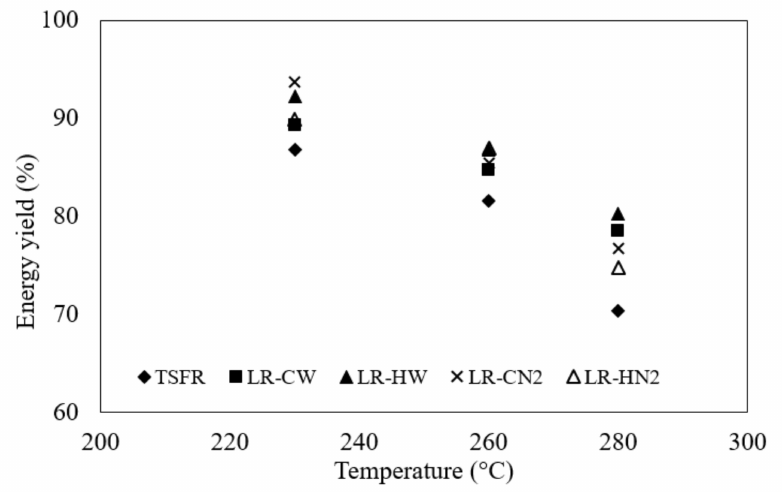
Figure 10. The relationship between torrefied temperature and energy yield.